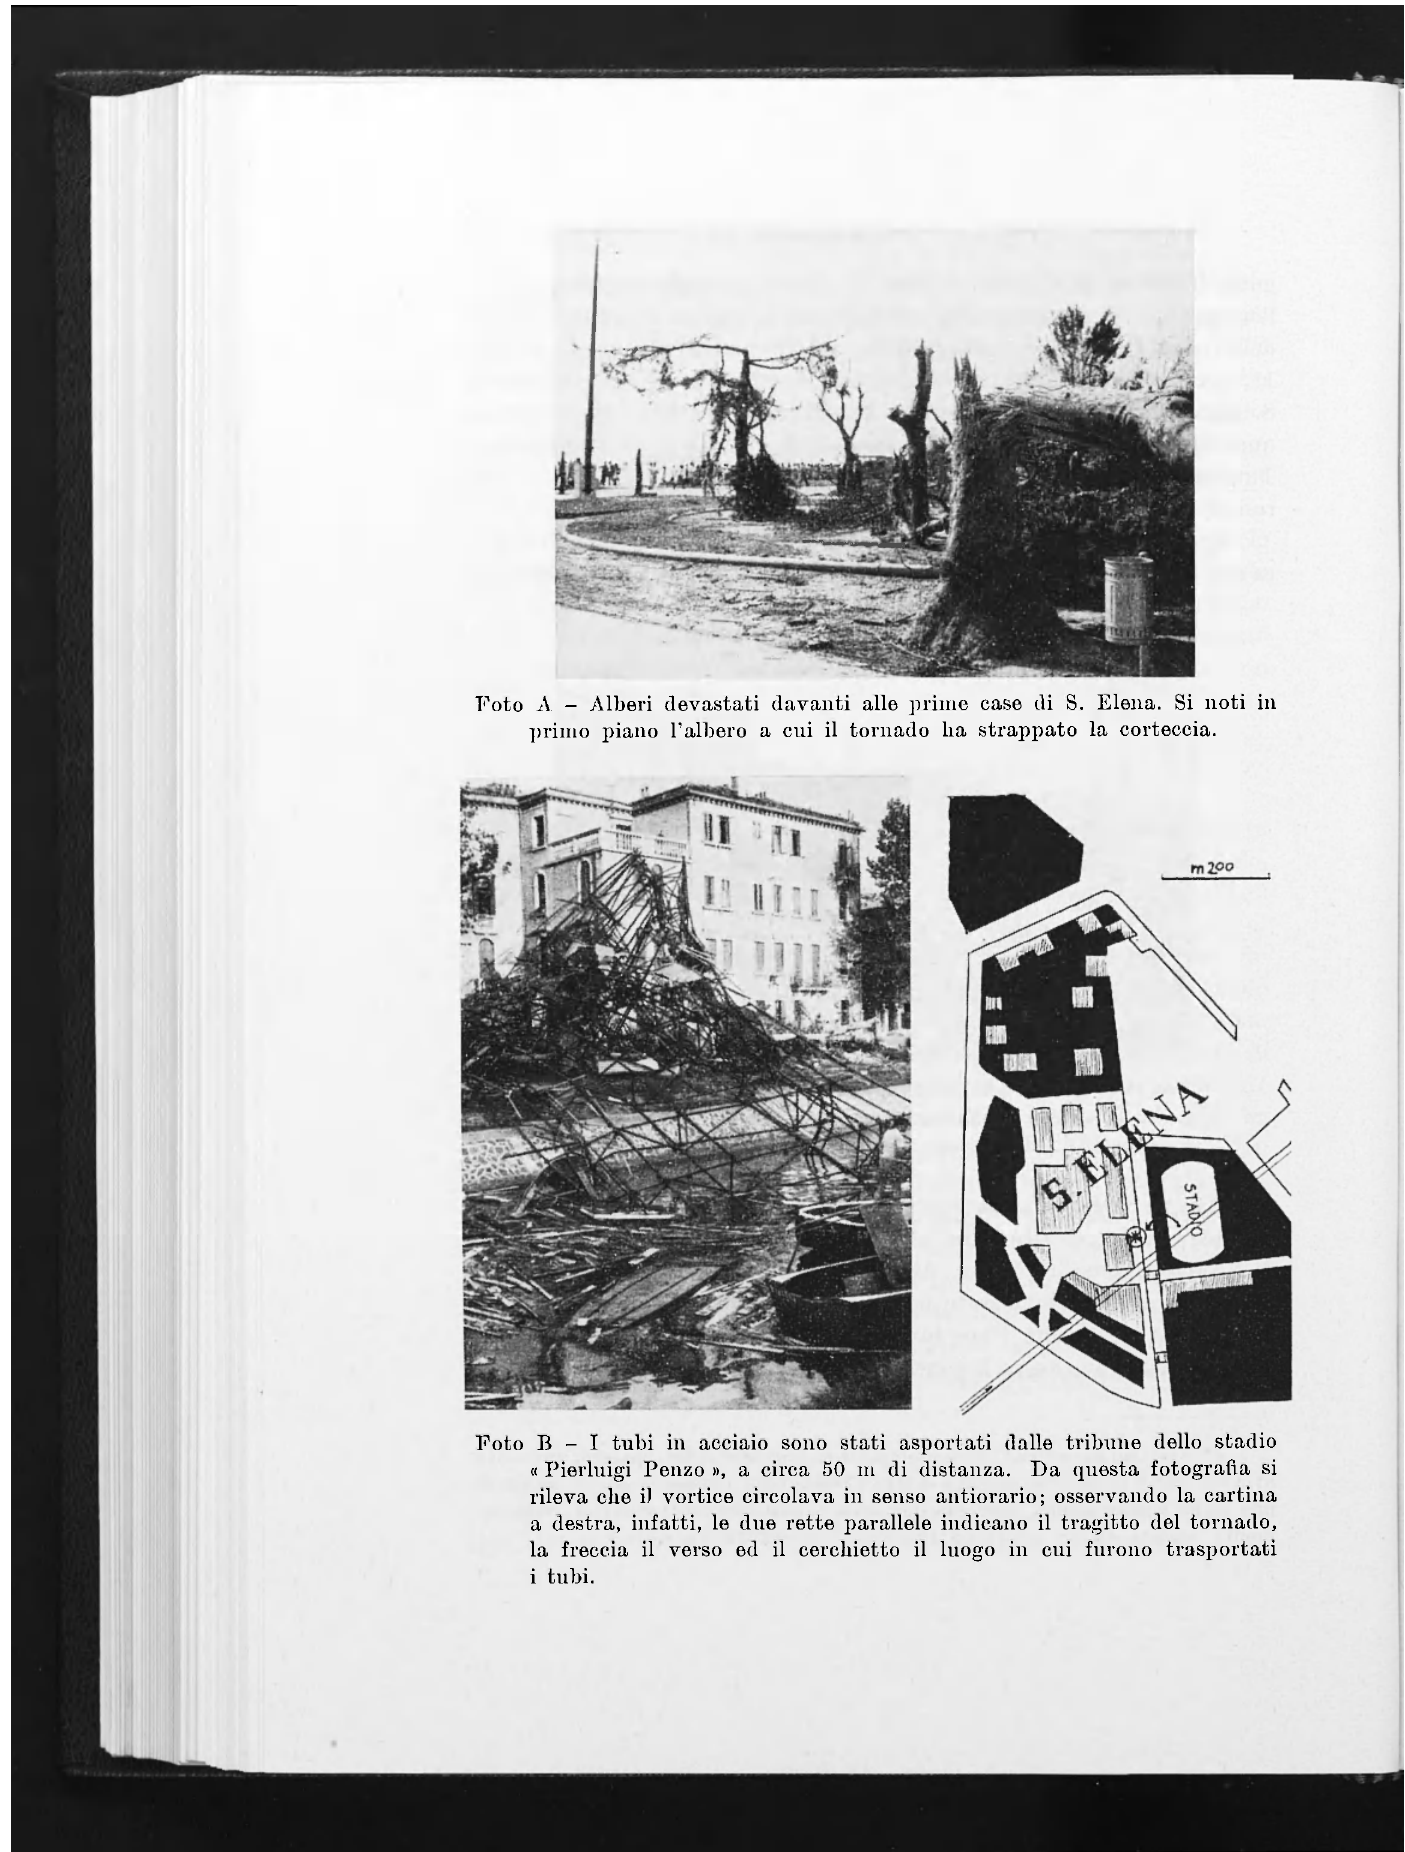
Foto A - Alberi devastati davanti alle prime case di S. Elena. Si noti